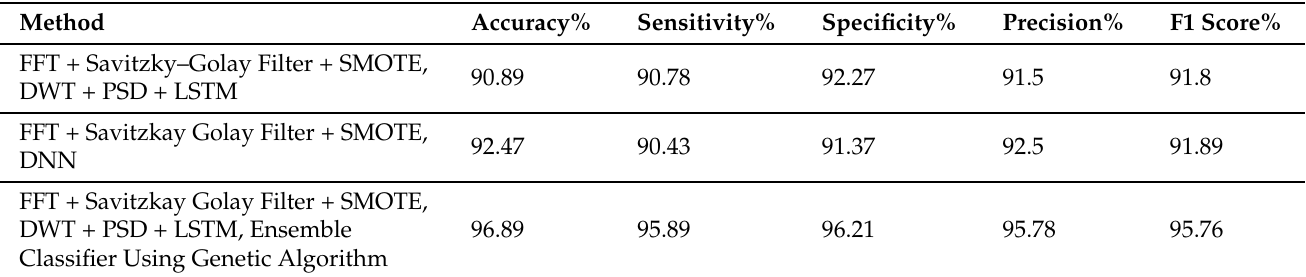
Table 5. Comparison of different classification techniques in terms of accuracy, sensitivity, specificity, precision, and F1 score.